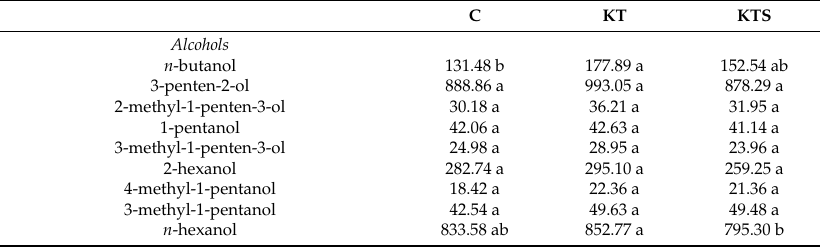
Table A1. Concentration of volatile compounds ( µ g / L) in red wines after 7 days of treatment. In the same row, di ff erent letters indicate significant di ff erences according to Tukey’s test ( p < 0.05). n = 3. C: untreated, KT: solid chitosan, KTS: dissolved chitosan. * Wines were added of volatile phenols.